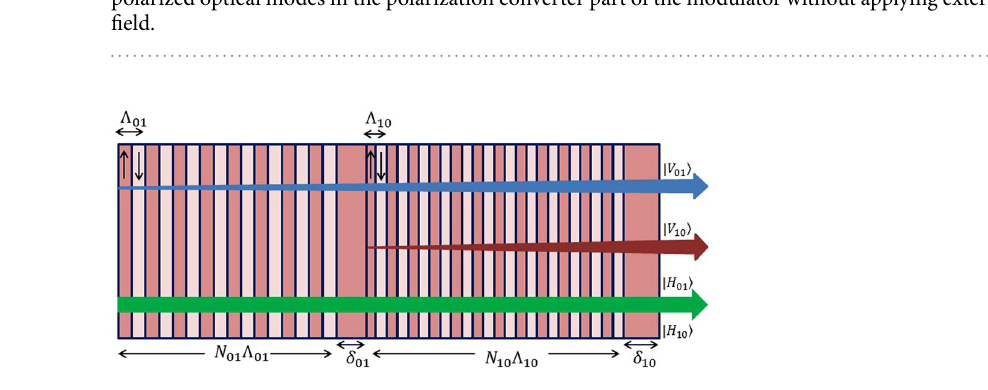
Figure 5. Schematic representation of polarization converter part (| TE 01 〉 ⇔ | TM 01 〉 and | TE 10 〉 ⇔ | TM 10 〉 ). Blue and red arrows display the productions of | TM 01 〉 and | TM 10 〉 from the first and second sections with domain wavelengths of Λ 01 and Λ 10 , respectively. The green arrow shows that input | TE 01 〉 and | TE 10 〉 modes are not changed when external electric field is not